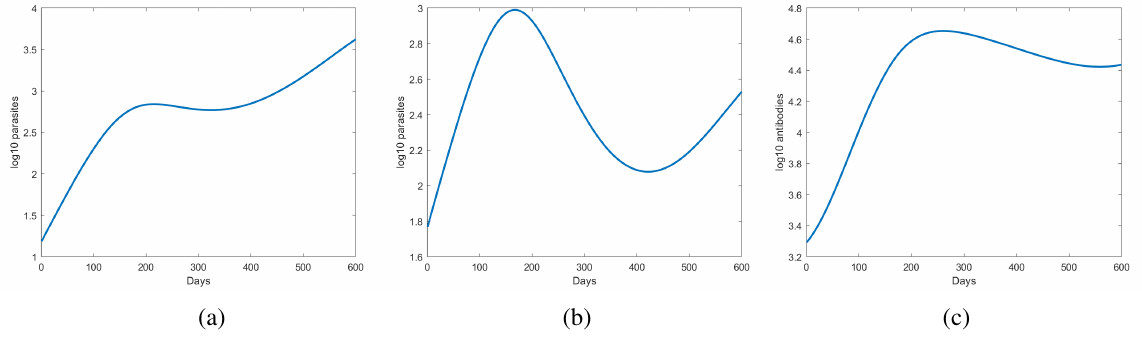
Fig. 2: Figures (a) and (b) show simulations of the parasites in the skin and bone marrow, respectively, in log values. Figure (c) shows simulations of log 10